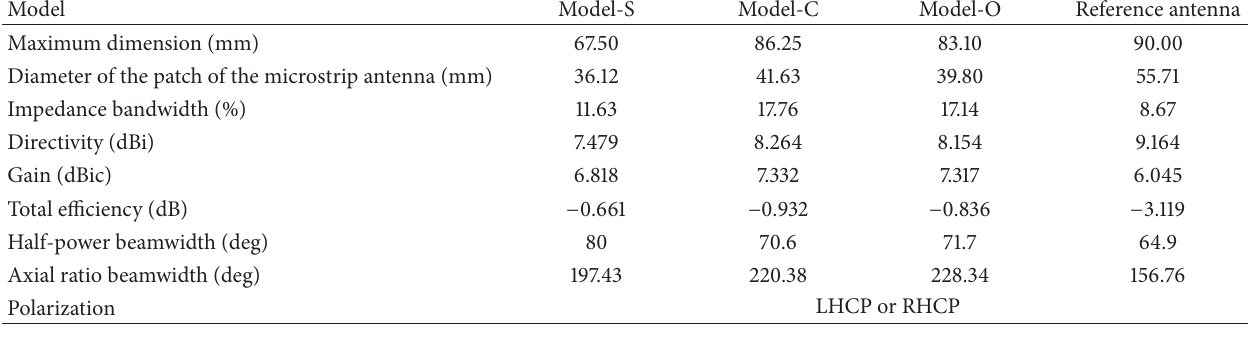
Table 3: Simulated results of the circular microstrip antenna with AMC structures at the operating frequency of 2.45 GHz.